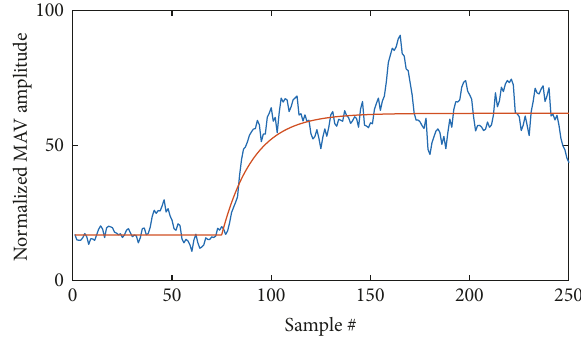
Figure 6: Example of the segment switching with AR(1) model (a one-dimensional VAR(1) model) with the forced one segment per movement. Blue line represents MAV feature dynamics when switchingfromareststatetoamovement,andtheredlinerepresents example of a single AR segment optimized for that movement.